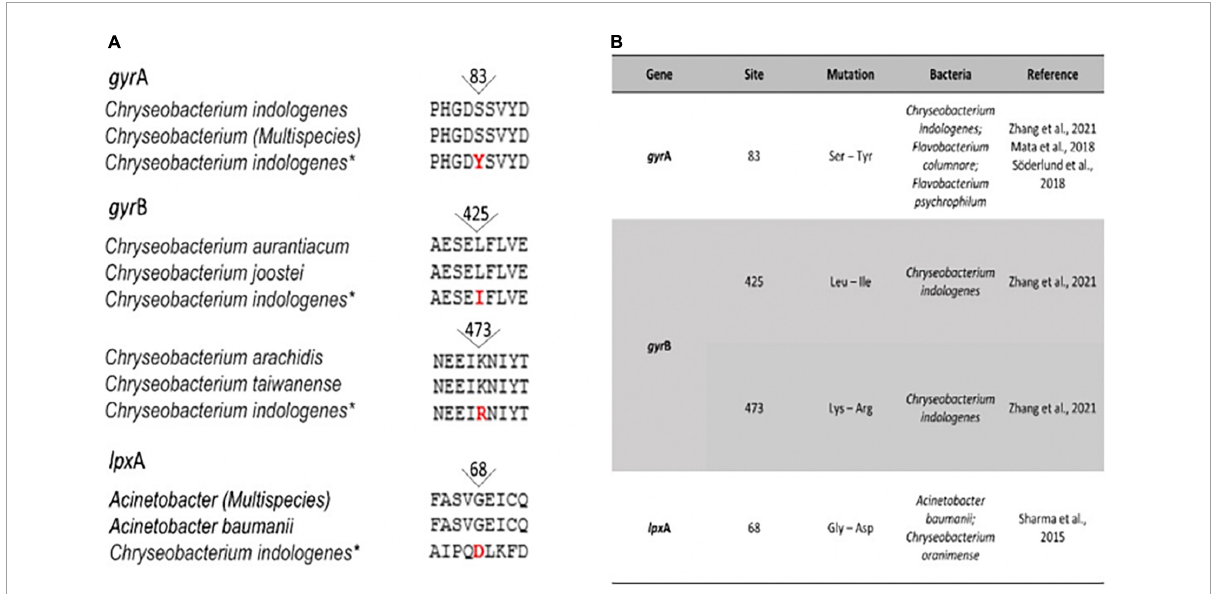
FIGURE6 (A) Amino acid sequence alignment for the GyrA QRDR (Ser83Tyr) of Chryseobacterium ureilyticum , Chryseobacterium (Multispecies), Chryseobacterium indologenes *; GyrB QRDR (Leu425Ile) of Chryseobacterium aurantiacum , Chryseobacterium joostei , Chryseobacterium indologenes * and GyrB QRDR (Lys473Arg) of Chryseobacterium arachidis , Chryseobacterium taiwanense , Chryseobacterium indologenes *; and mutations in lpxA (Gly68Asp) of Chryseobacterium (Multispecies), Acinetobacter baumanii, Chryseobacterium indologenes *. (B) Known mutations in genes conferring resistance to quinolones (GyrA and GyrB QDDR) and colistin (lpxA). *Strain isolated in this